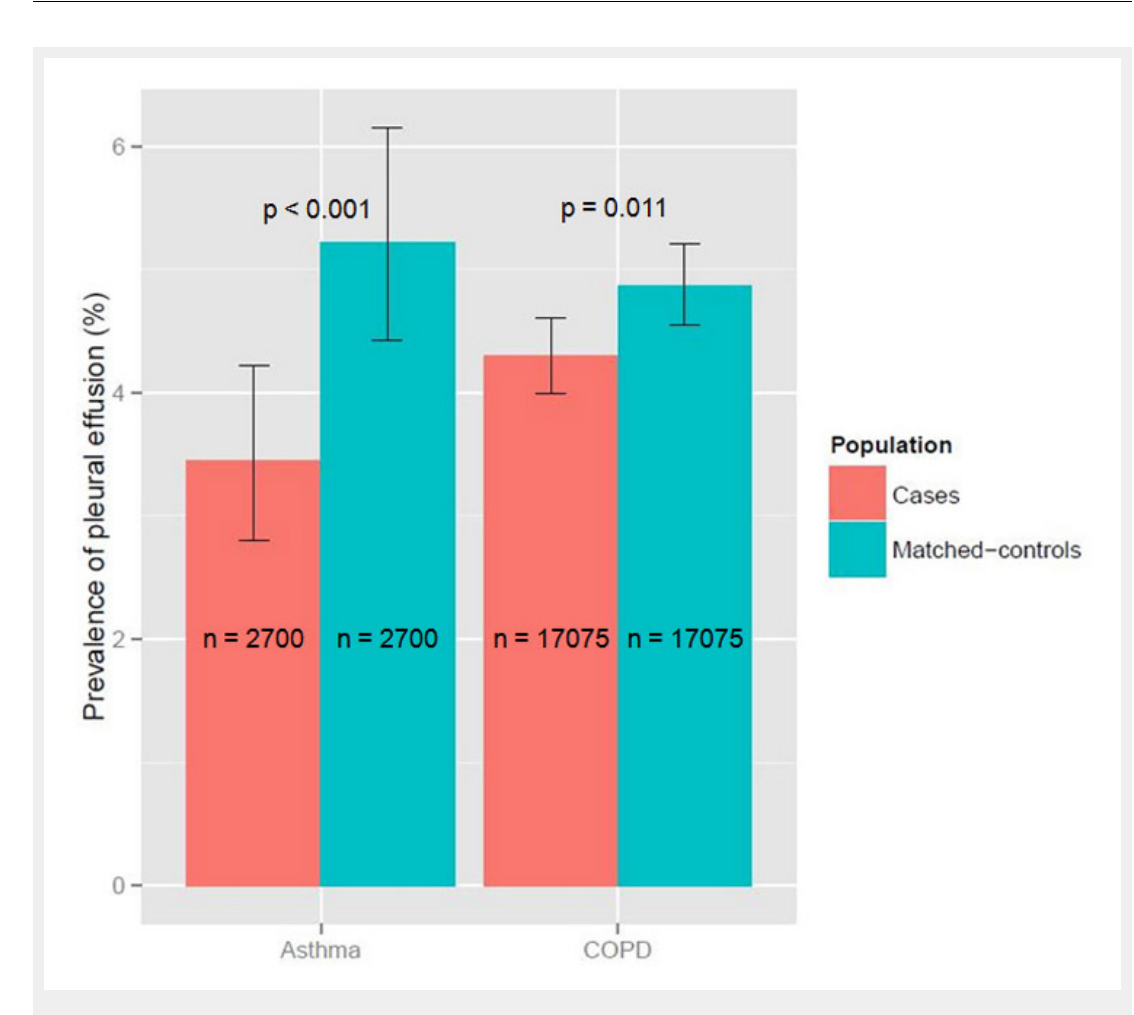
Figure 1 Prevalence of pleural effusion in hospitalised COPD and asthma patients compared to their matching controls without lung